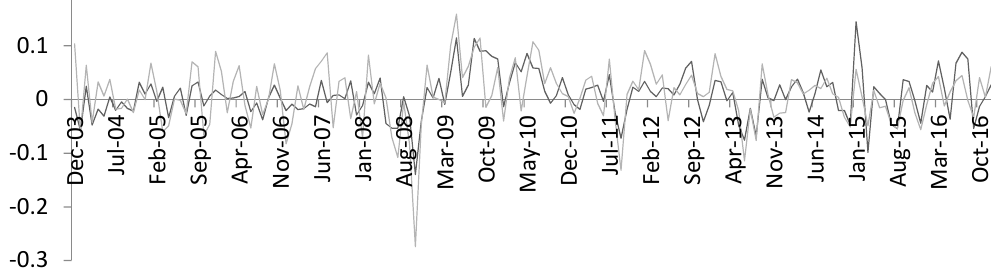
Figure 5. Growth rate based indexes.